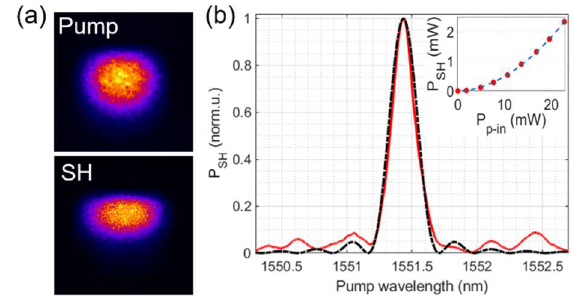
Fig. 3. (a) Recorded pump and SH mode intensities of the 10 µm wide RPE PPLN ridge waveguide (b) Measured (red solid) and calculated (black dashed) SHG tuning curve. Inset: low power P SH vs. P p-in (circles) with a parabola fit (dashed). P SH and pump conversion efficiency into SH wave, defined as η SHG = 100 %ꞏP SH /P p-in , vs. P p-in are plotted